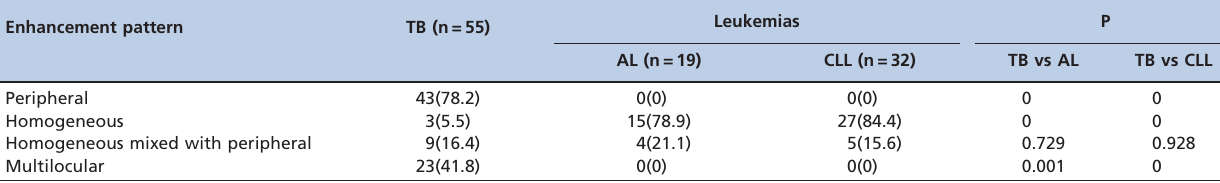
Table 2 - Comparison of enhancement patterns between tuberculosis and leukemias. Enhancement pattern